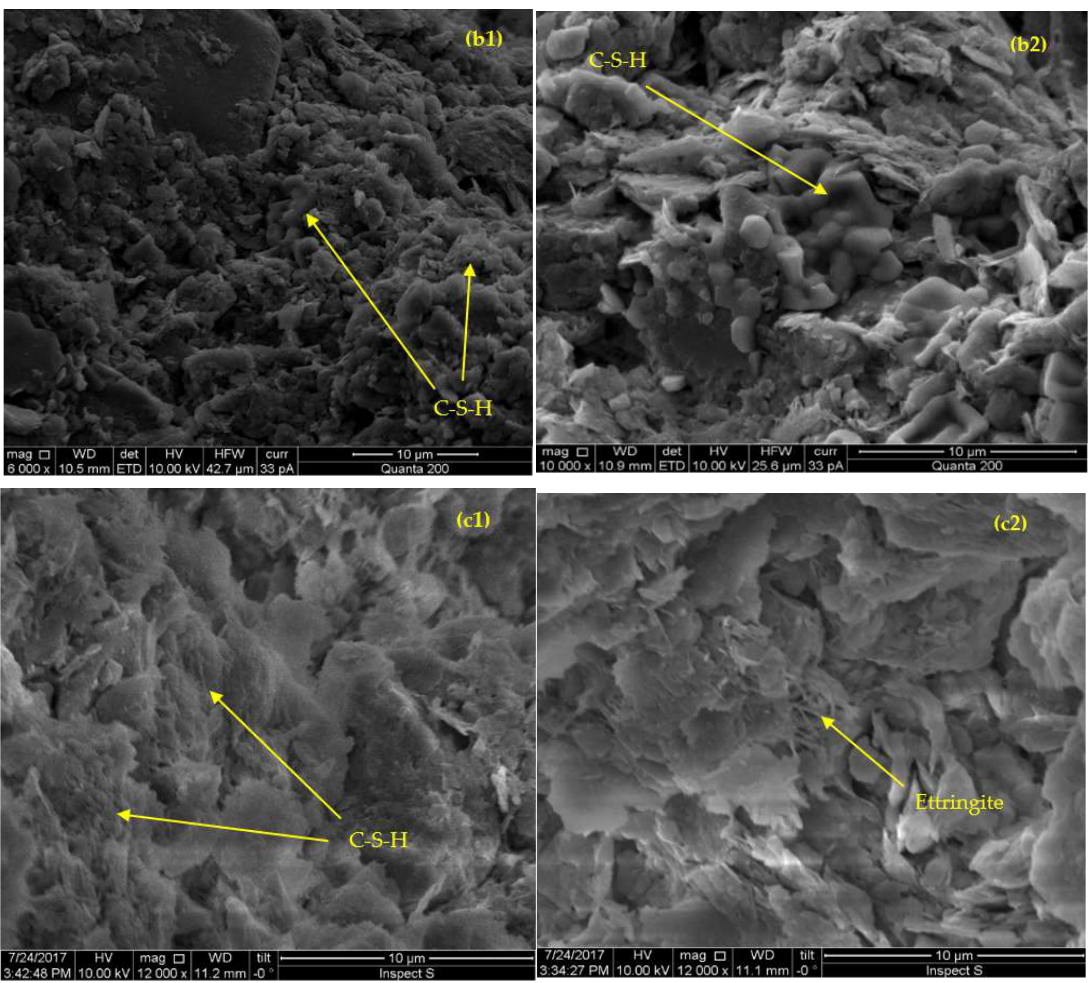
Figure 8. SEM of ( a ) untreated soil (U), ( b1 , b2 ) soil with 6% binary binder (25%GGBS, 75%CKD) (25G-75C) at 7 days, ( c1 , c2 ) soil with 6% binary binder (25%GGBS, 75%CKD) (25G-75C) at 28 days.